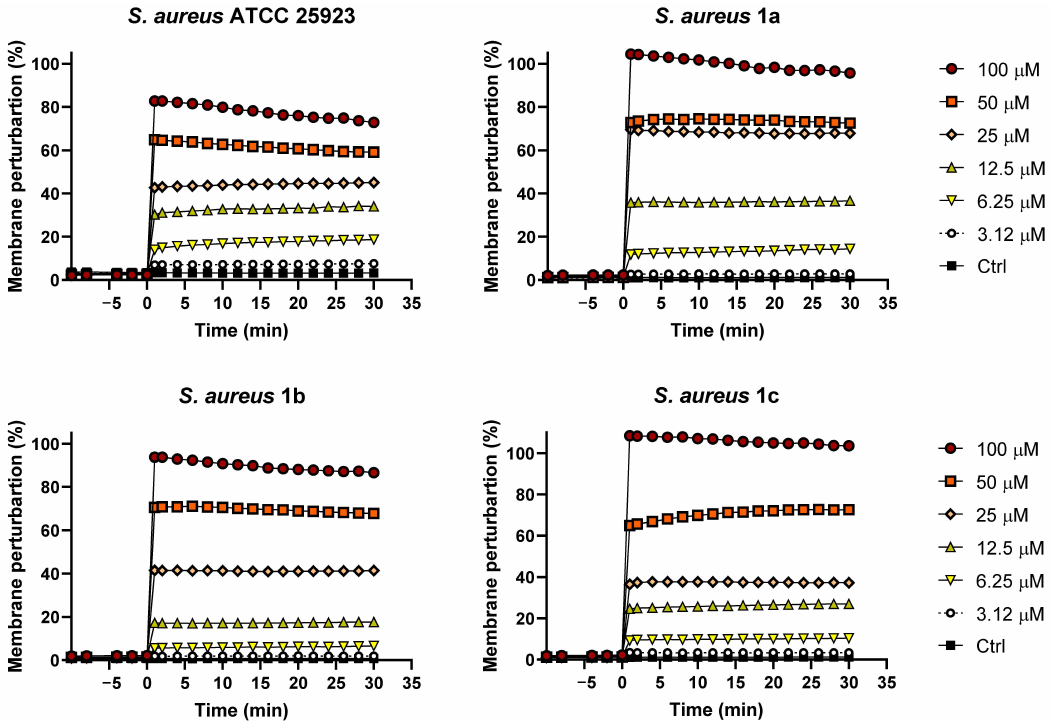
Figure 2. Membrane perturbation assay performed with the Sytox Green dye. The percentage of membrane damage was calculated with respect to the maximum membrane permeabilization obtained by the highest peptide concentration (100 µM) and the addition of 1 mM EDTA plus 0.5% Triton X-100. Time 0 indicates the addition of the peptide. Data points are the mean of triplicate measurements from a single experiment representative of three independent experiments. Controls (Ctrl) are cells not treated with the peptides.